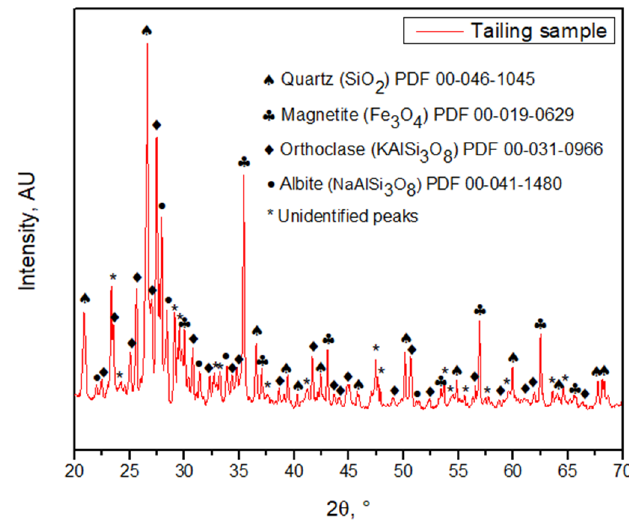
Figure 5. XRD diffractogram of the tailing sample.